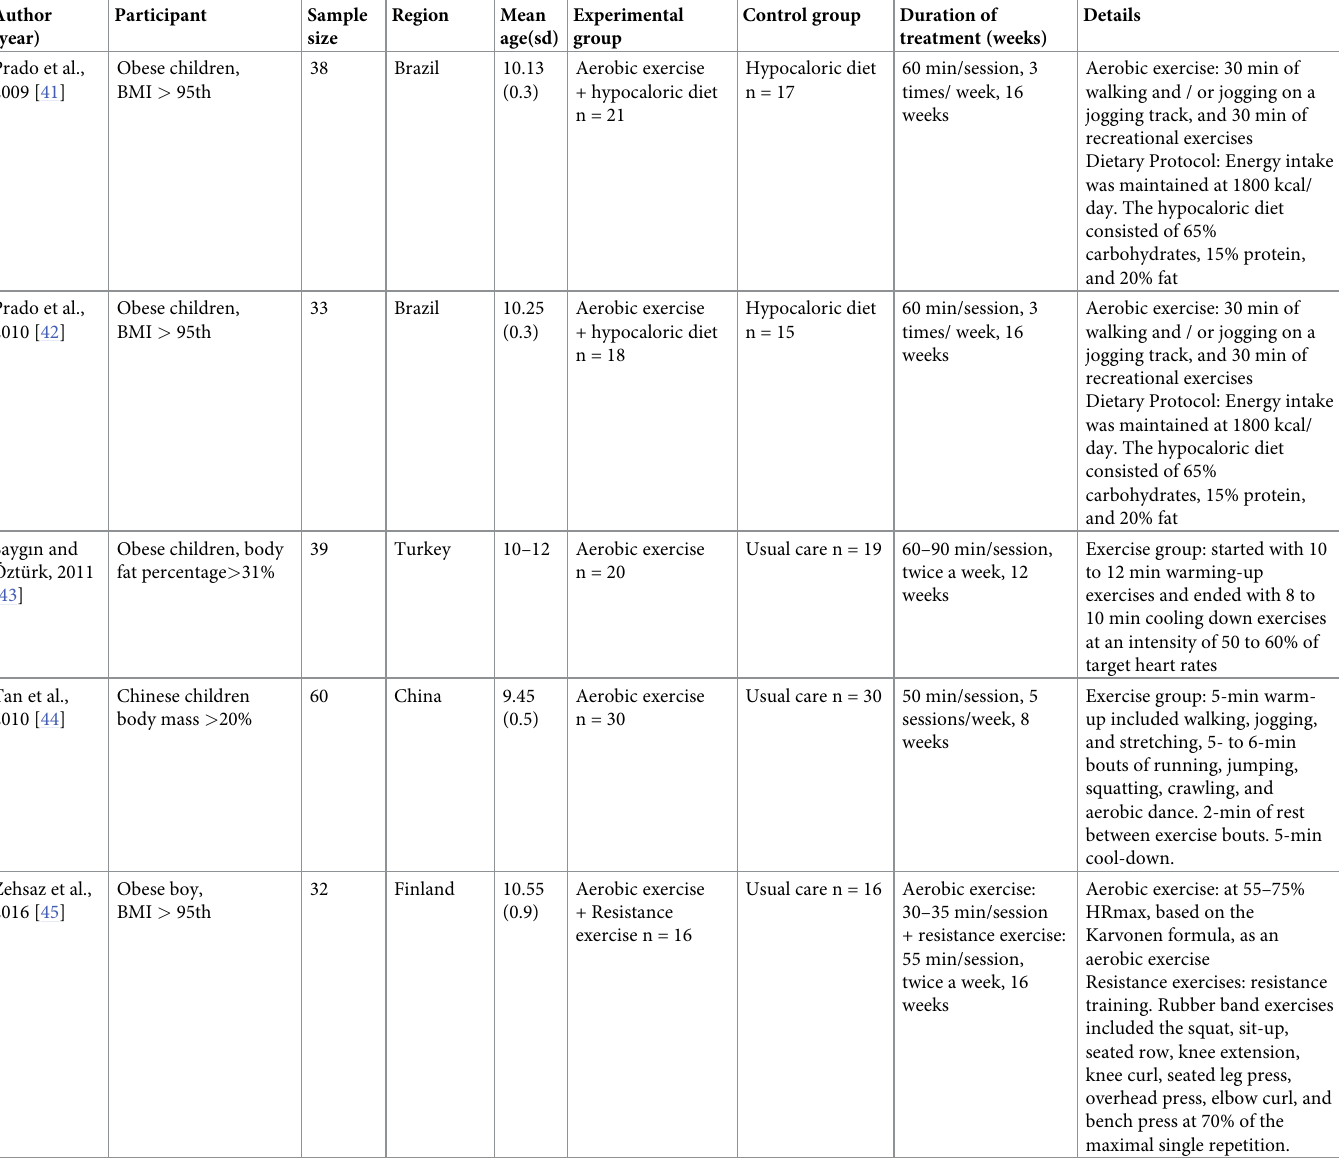
Aerobic exercise: 30 min of walking and / or jogging on a jogging track, and 30 min of recreational exercises Dietary Protocol: Energy intake was maintained at 1800 kcal/